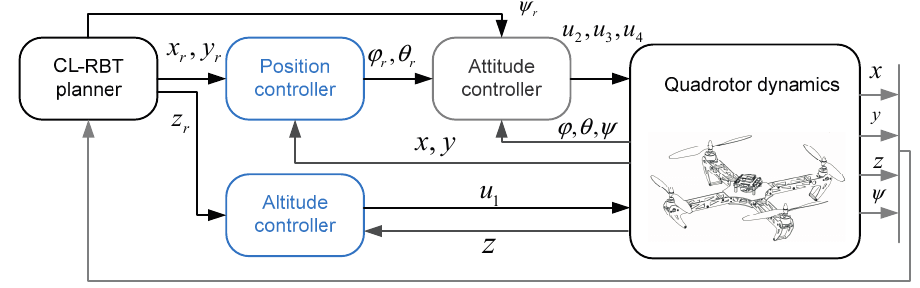
Figure 4. Cascaded control scheme of the quadrotor MAV. CL-RBT, closed-loop random belief